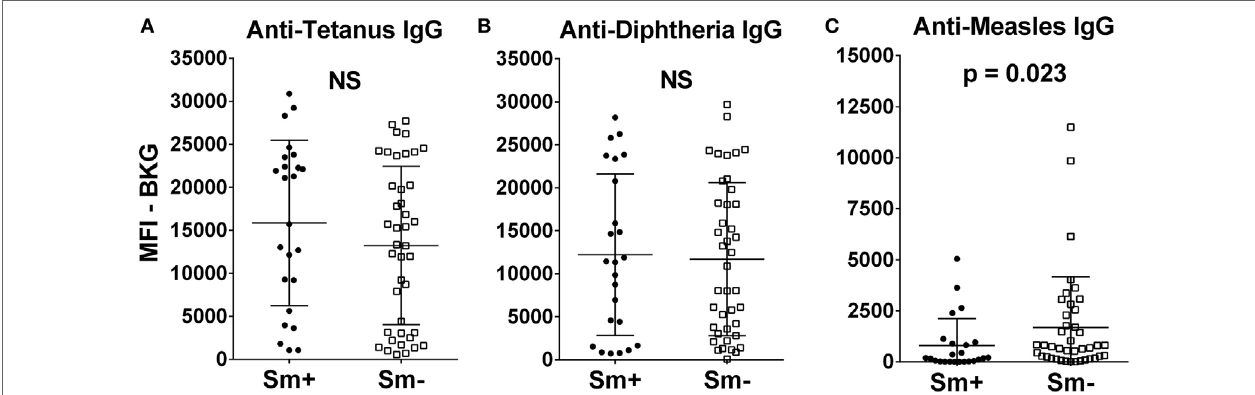
FigUre 1 | Anti-tetanus IgG (a) , anti-diphtheria IgG (B) , and anti-measles IgG (c) levels at 2 years of age of infants born to mothers who were either egg positive (Sm + , represented by solid circles) or egg negative (Sm − , represented by solid squares) for Schistosoma mansoni . All IgG responses are shown as median fluorescence intensity (MFI) minus background (BKG). Data are presented as dot plots with means at centerline, and whiskers representing the SD. Comparison was done by Mann–Whitney U test. NS, not